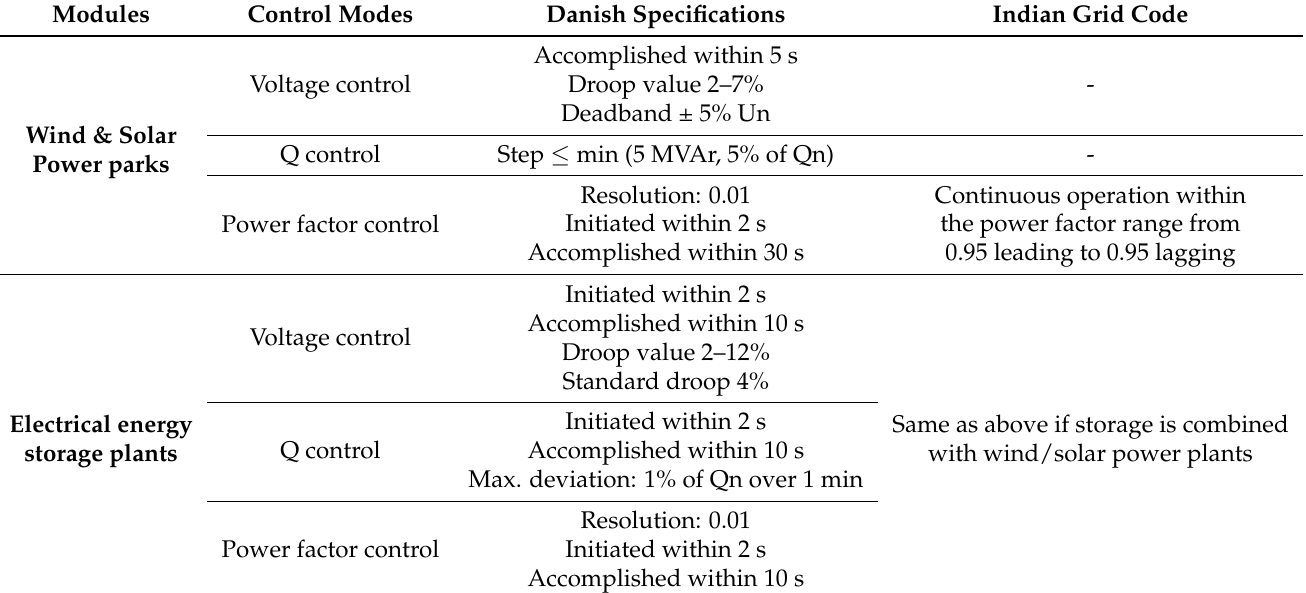
Table 6. Reactive power control modes for power generating units and electrical energy storage units in Denmark and India. Modules Control Modes Danish Specifications Indian Grid